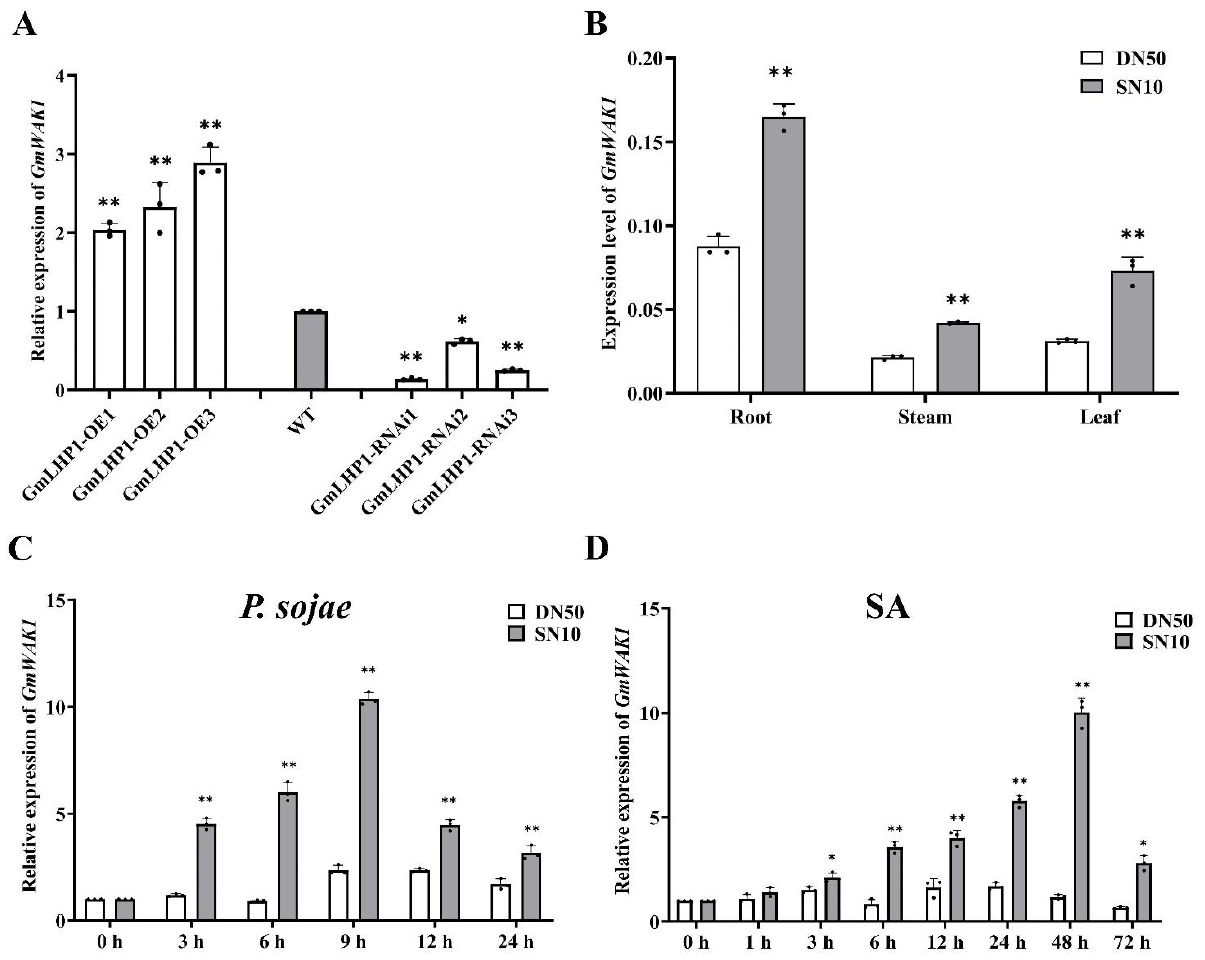
Figure 1. Analysis of expression of GmWAK1 by quantitative real-time PCR (qRT-PCR) . ( A ) Expression of GmWAK1 genes, GmLHP1- overexpressing (OE), RNAi transgenic plants, and WT plants. ( B ) Tissue specificity analysis of ‘Dongnong50’ and ‘Suinong10’ of GmWAK1 gene. ( C ) Relative GmWAK1 expression at different times (0, 6, 12, 24, 48, and 72 h) after Phytophthora sojae ( P. sojae ) infection of ‘Suinong 10’ and ‘Dongnong 50’. ( D ) Relative GmWAK1 expression at different times (0, 3, 6, 9, 12, and 24 h) after salicylic acid (SA) (0.5 mM) treatment in ‘Suinong 10’ and ‘Dongnong 50’. Three biological replicates, each with three technical replicates; * p < 0.05, ** p < 0.01, Student’s t test. Error bars indicate standard deviations.